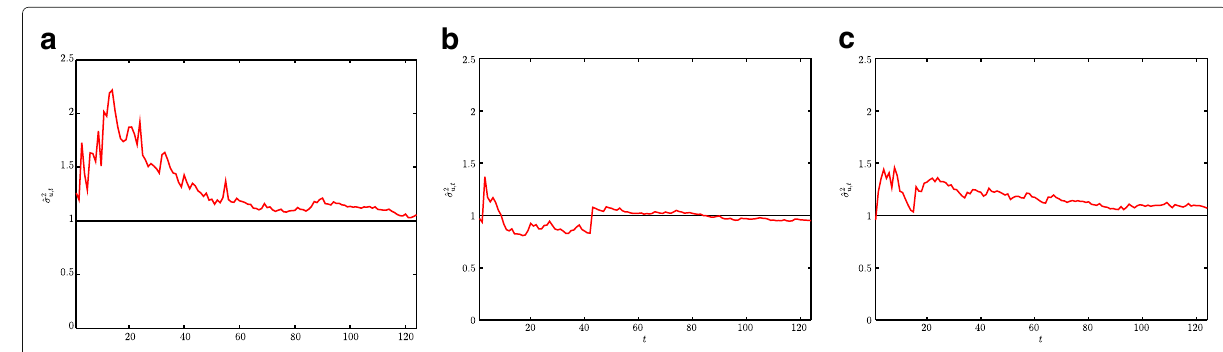
Fig. 3 True (black) and estimated (red) scale factor for the proposed SMC method with known ARMA parameters. a AR(1), H = 0.9. b MA(1), H = 0.9. c ARMA(1,1), H =